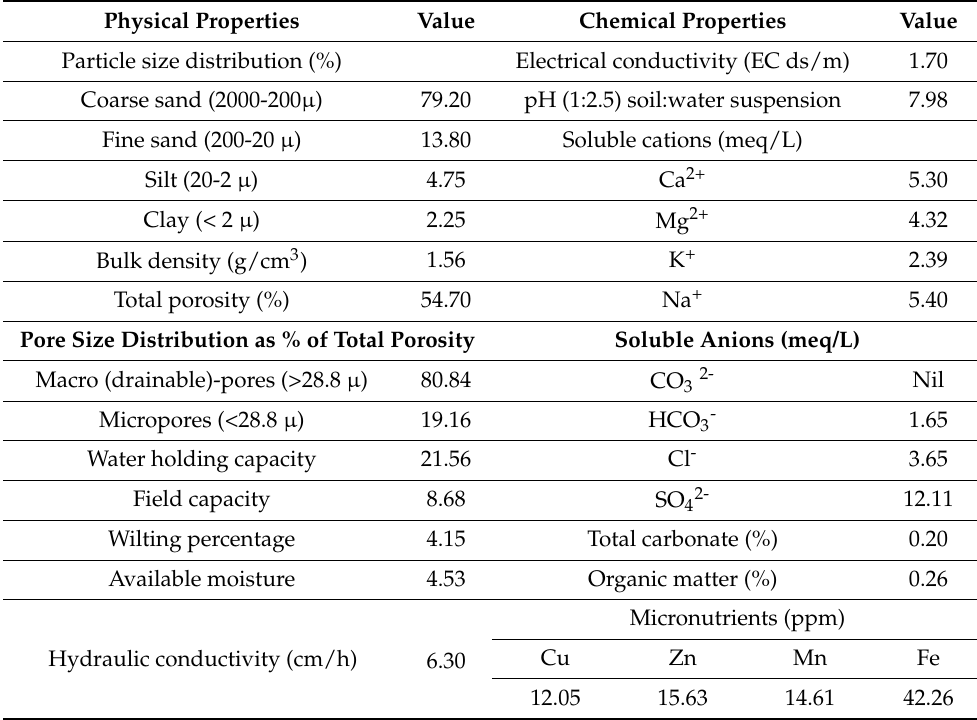
Table 1. Some physical and chemical properties of experimental soil before planting.